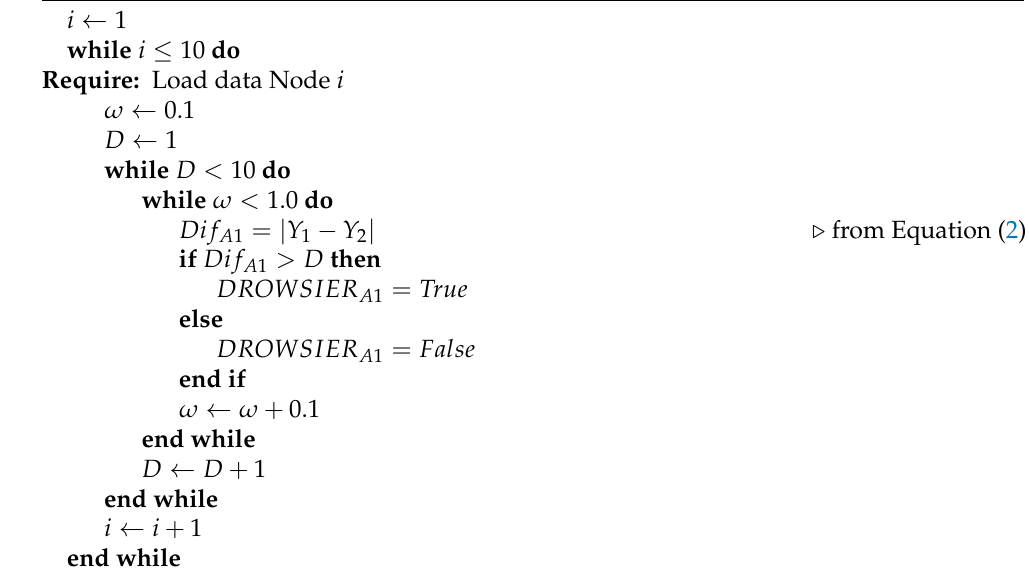
Algorithm 1 Pseudocode algorithm for testing the parameters of Exponential smoothing algorithm— A